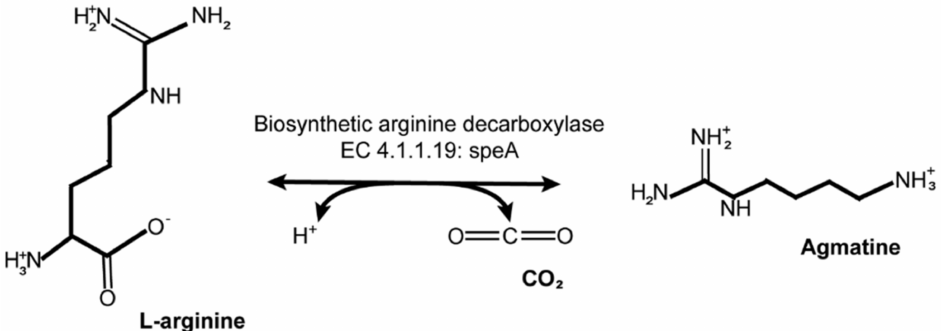
Figure 4. MetaCyc pathway for bacterial conversion of arginine to agmatine (ID: PWY0 − 1299)